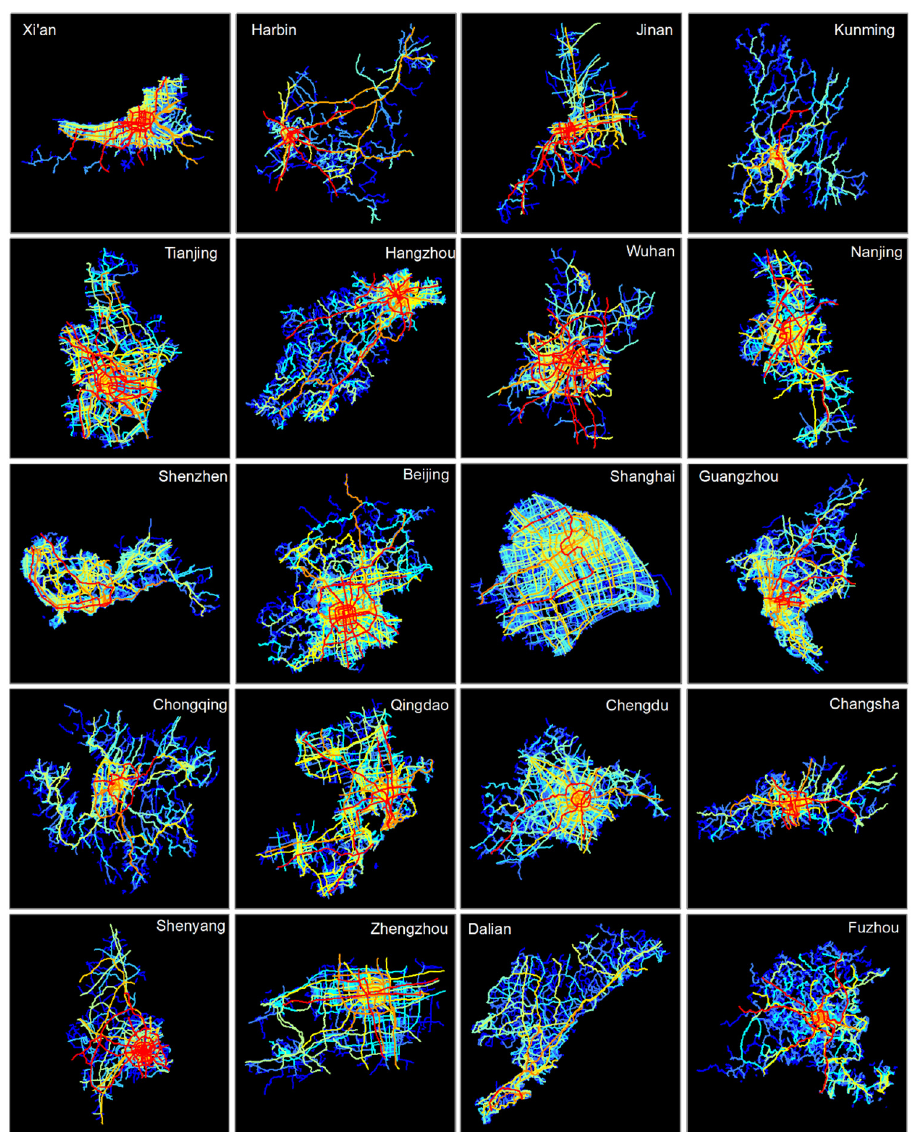
Figure 8. (Color online) The fractal pattern of far more less-connected streets than well-connected ones across top 20 cities by GDP in China. (Note: A spectrum of color is adopted to visualize the city’s street structure, with red and blue representing the best-connected and poorest-connected streets, respectively; the other colors (in cyan, yellow, and orange) represent the streets in between).